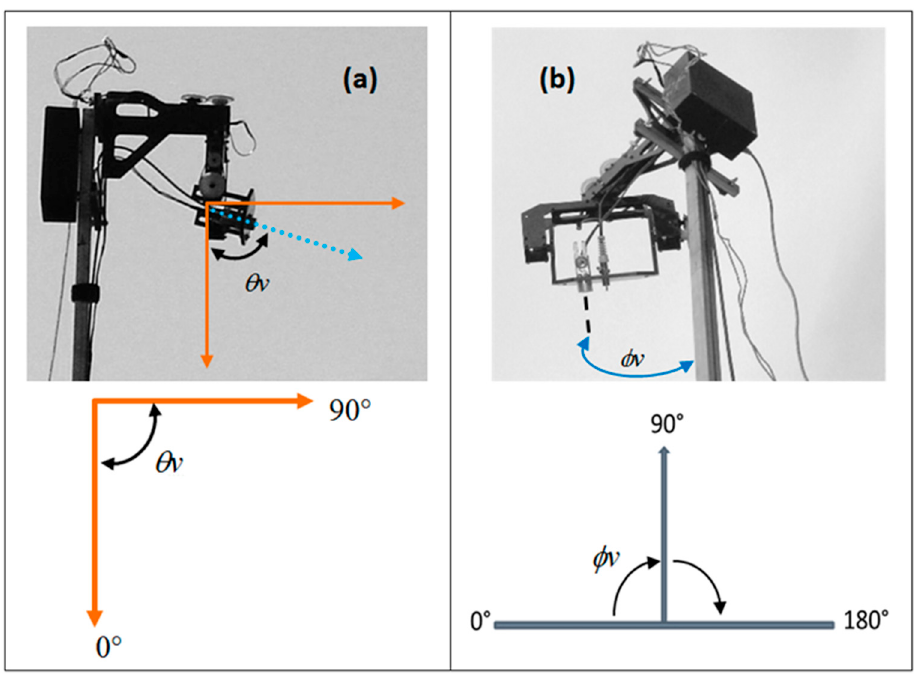
Figure 4. Geometry of the footprint-measuring device. ( a ) Zenith plane, ( b ) azimuth plane